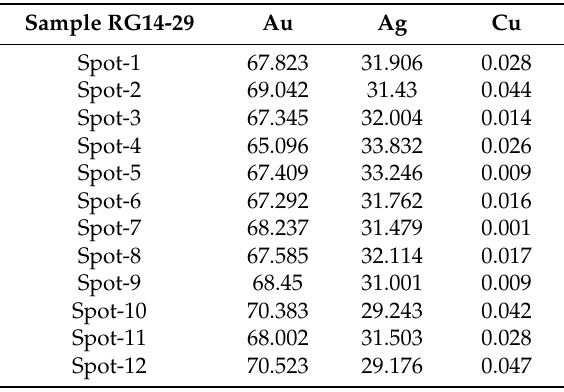
Figure 5. Paragenesis diagram showing the relative geochronology of the various mineral phases for the Myra Falls mine. Vein alteration minerals are shown in grey. The width of the bars is indicative of the relative mineral abundance. The dashes indicate waning or intermittent precipitation. Table 1. Electron microprobe (wt %) data for